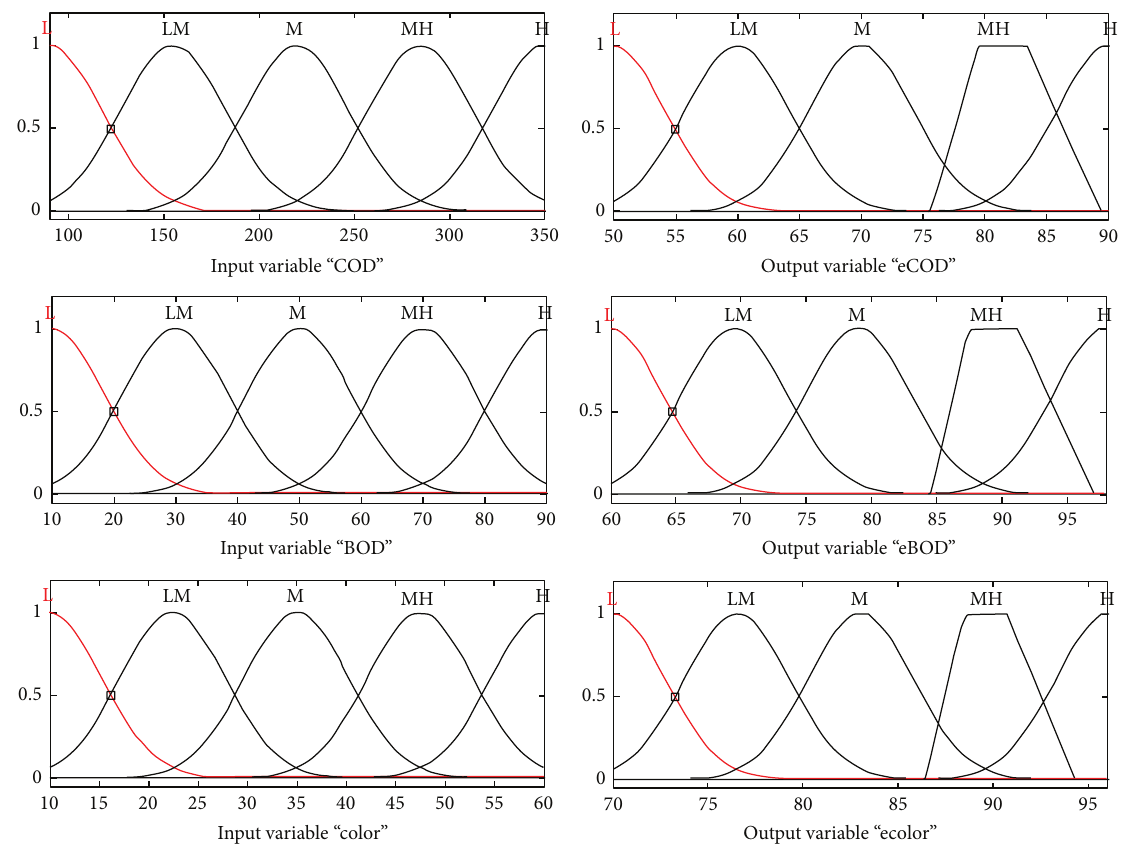
Figure 5: Membership